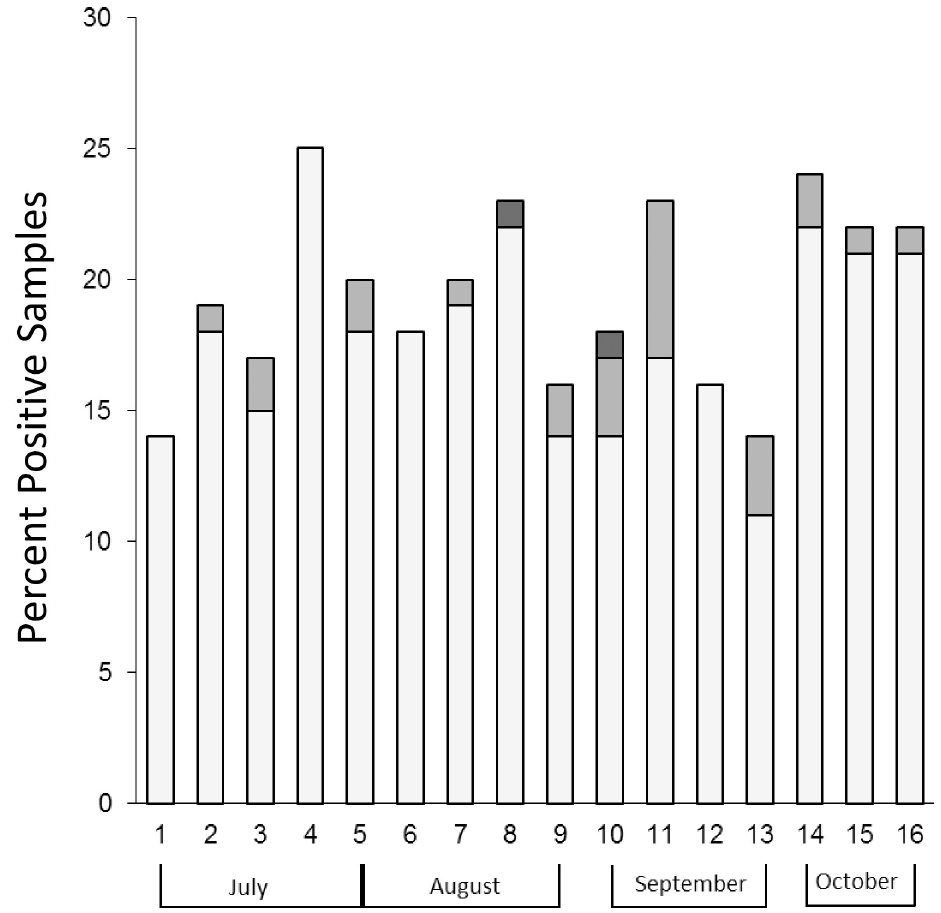
Fig 1. Prevalence of positive samples during the study period. The number of C . jejuni (light grey), C . coli (medium grey) and C . lari (dark grey) isolated each week from 30 packages of retail poultry cuts.